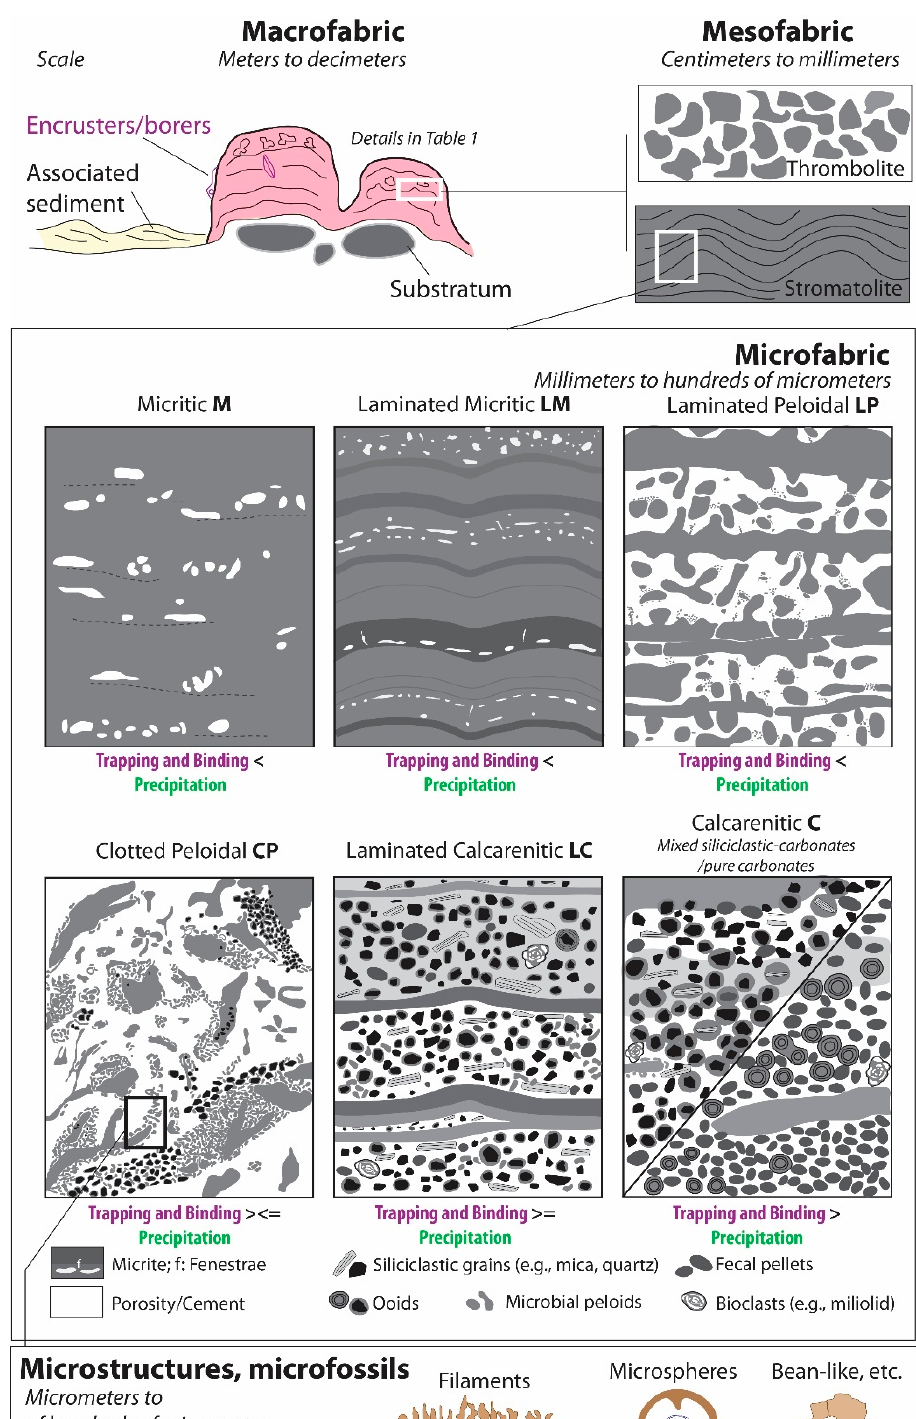
Figure 4. The various scales of microbialite fabrics used in this study.